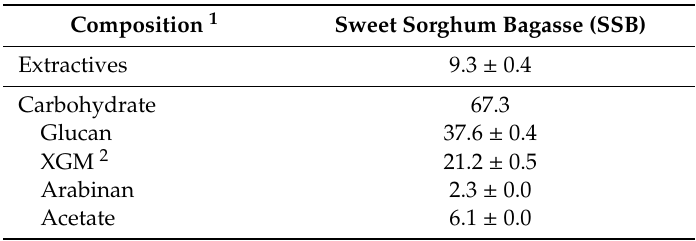
Table 1. Chemical composition of sweet sorghum (g / 100 g oven dry